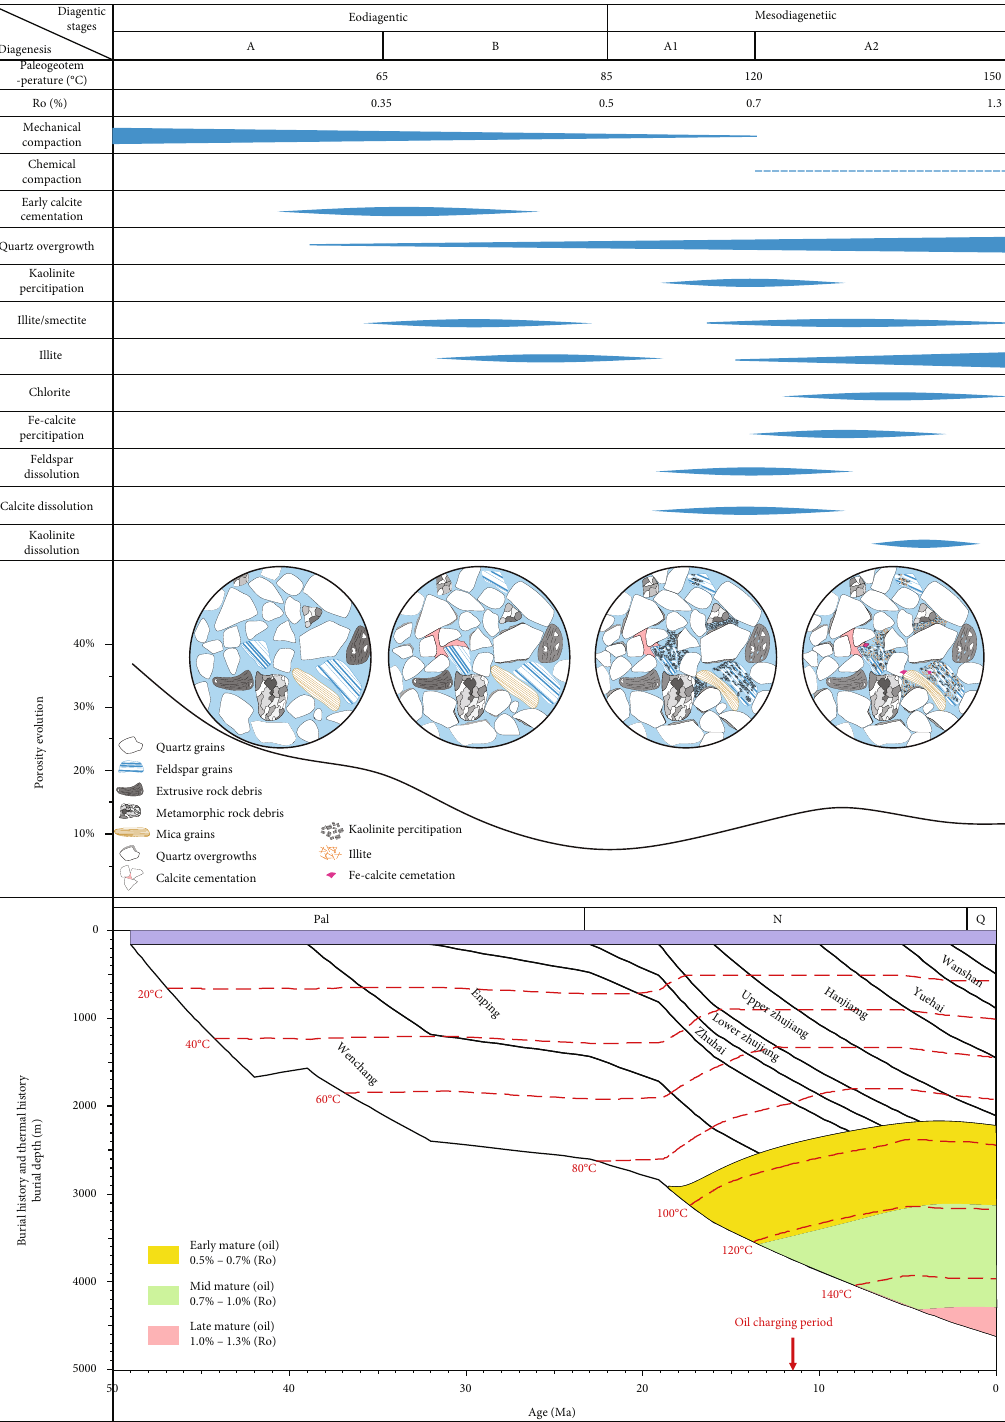
w sandstones in the Lufeng southern 2